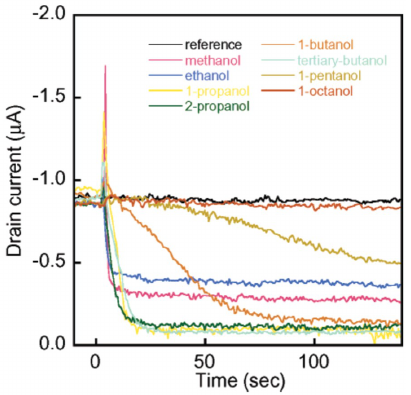
Figure 3. Drain current V sd = −100 mV are shown as a function of time for application of saturated vapor of various kinds of alcohols: methanol, ethanol, 1-propanol, 2-propanol, 1-butanol, tertiary-butanol, 1-pentanol, and 1-octanol. Reproduced with permission from ref. [18].